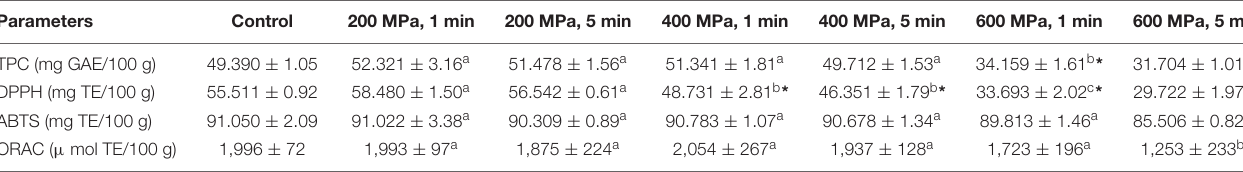
TABLE 4 | Polyphenol content and antioxidant capacity of control and high pressure processed cooked chickpeas.